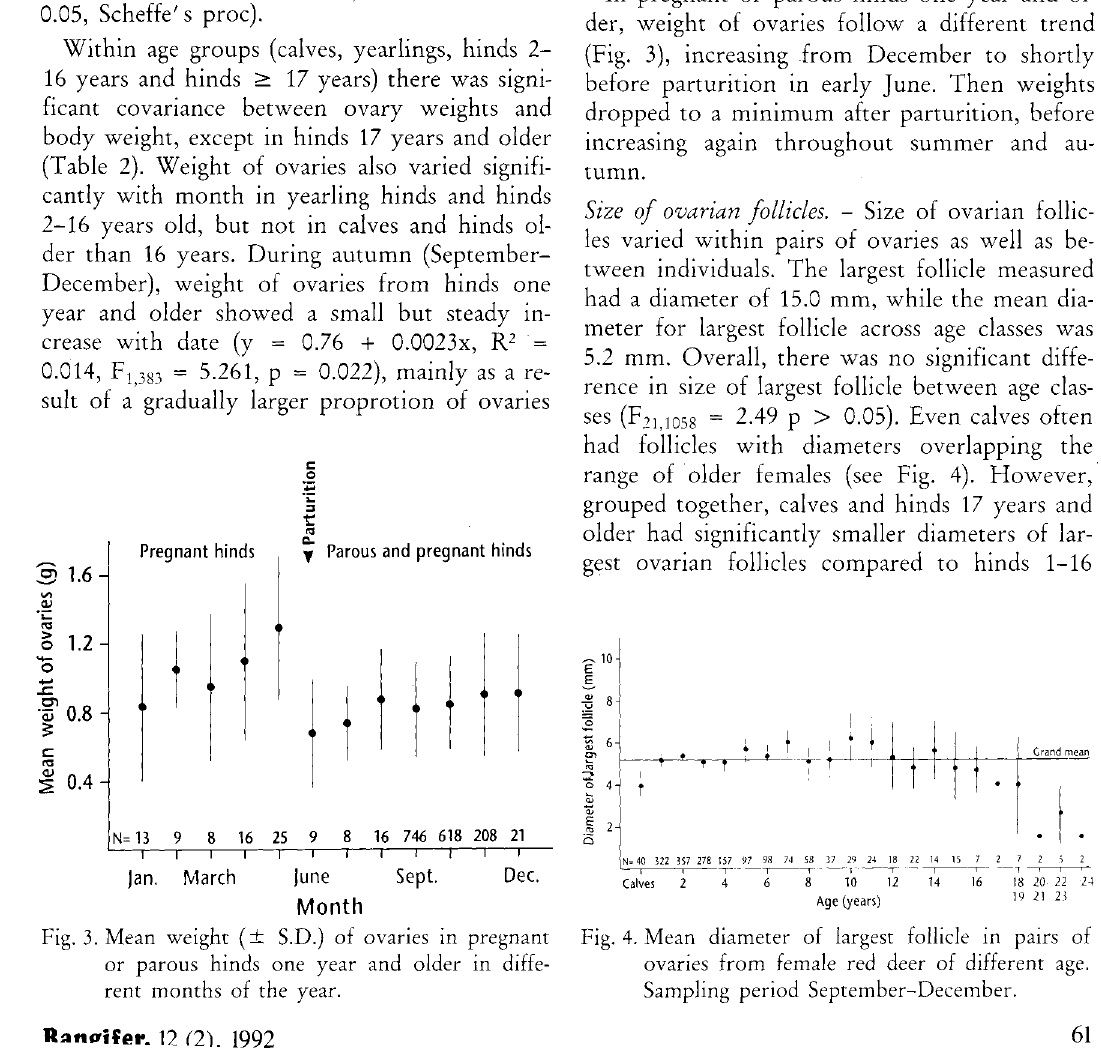
Fig. 2. Mean weight of ovaries (± S.D.) for different age classes of female red deer. Sampling period